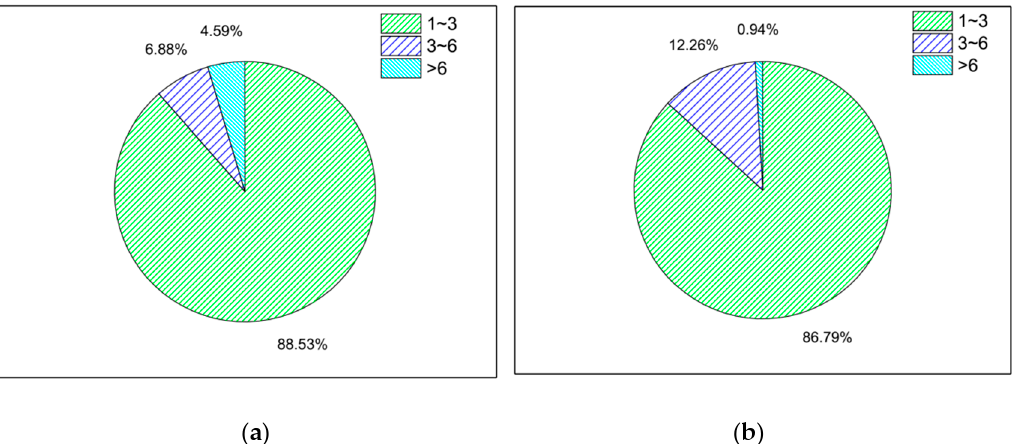
Figure 8. The pie distribution diagram of the average number are detected within the fine grain time. ( a ) In the bus. ( b ) Out of bus.